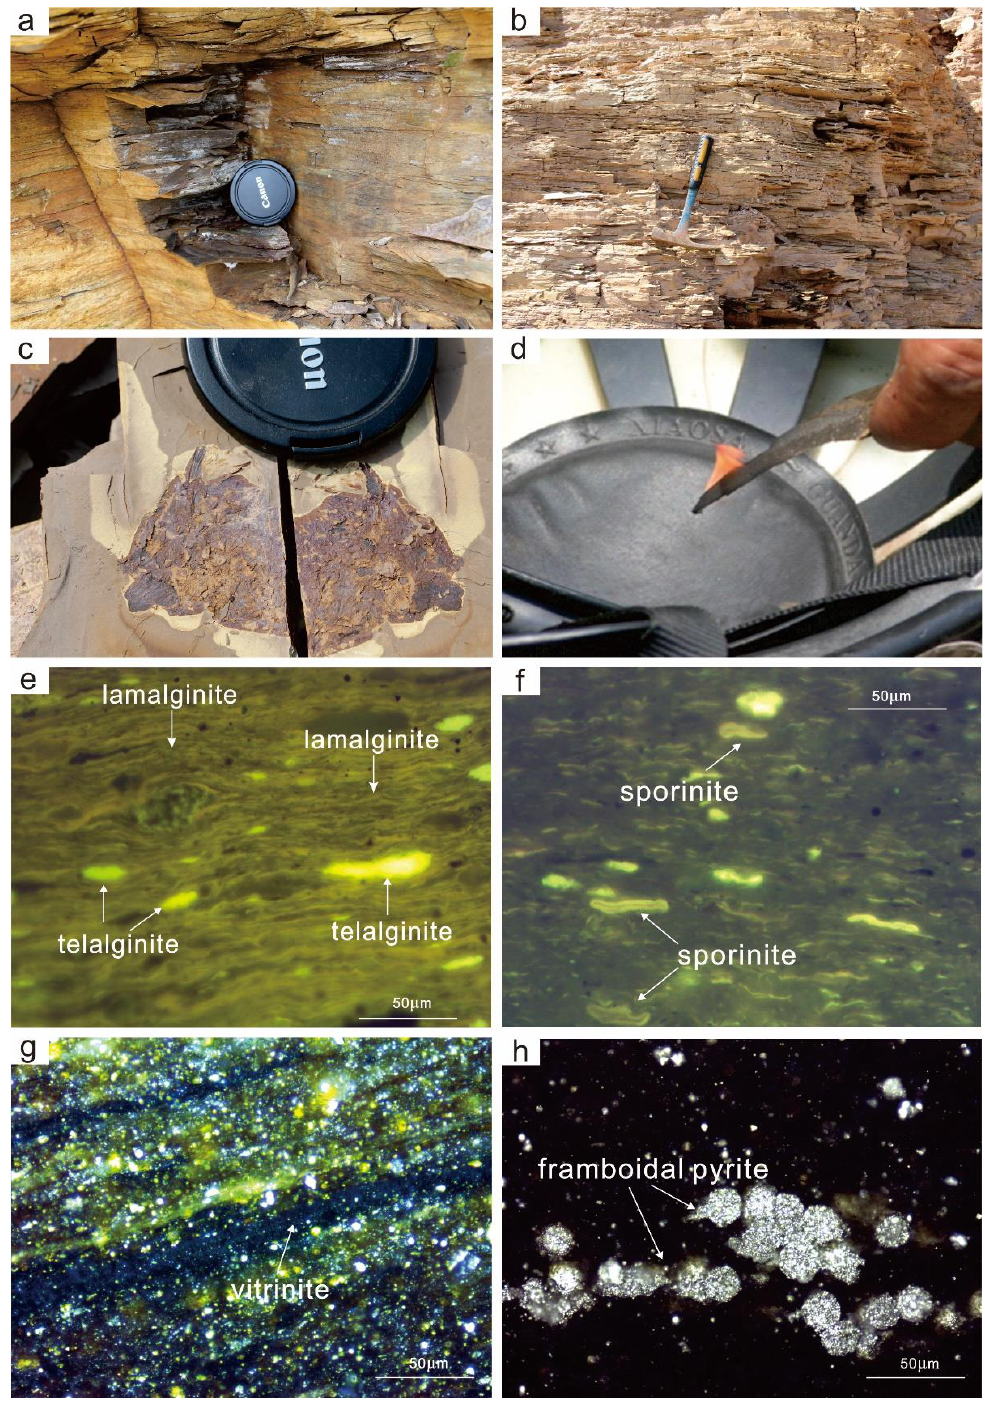
Figure 3. Oil shale characteristics of Youganwo Formation in Maoming Basin: ( a ) Brown-black oil shale; ( b ) the weathered color is yellowish white in the form of paper sheets; ( c ) animal fossils; ( d ) oil shale can be ignited; ( e ) JT01-7, Lamalginite and telalginite characteristics; ( f ) JT01-2, Sporinite characteristics; ( g ) YJ01-2, Vitrinite characteristics; ( h ) JT01-6, Pyrite characteristics.